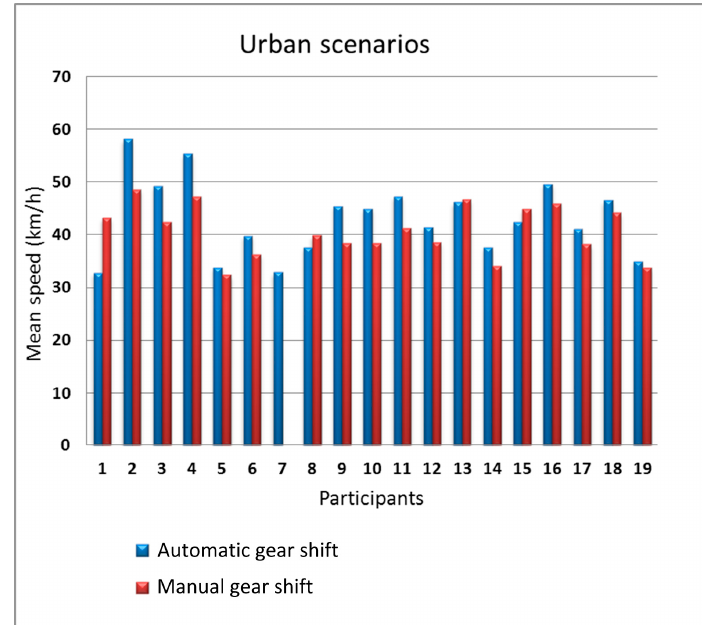
Figure 10. Mean speed as a function of the gear shift type in the urban scenarios.